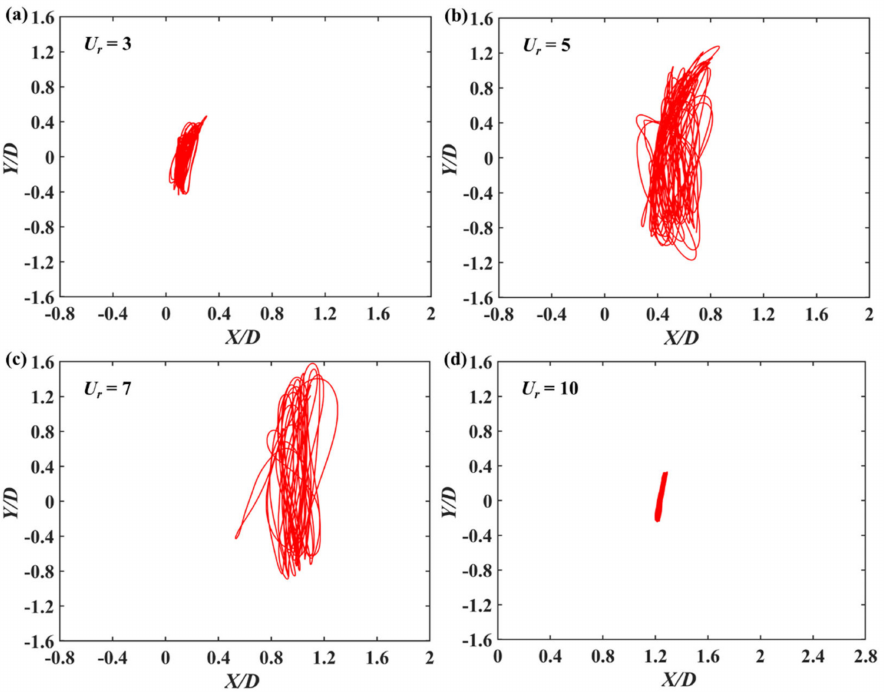
Figure 8. X-Y trajectory of two coupled cylinders at α = 90 ◦ and d/D = 0.3: ( a ) U r = 3; ( b ) U r = 5; ( c ) U r = 7; ( d ) U r =